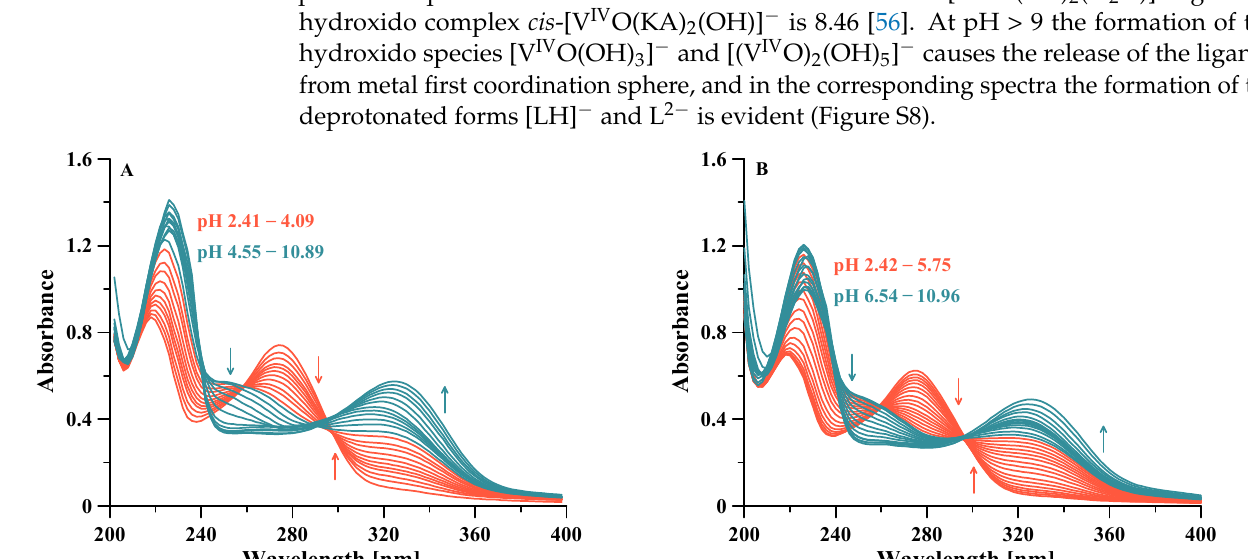
Figure 3. Representative spectra of V IV O 2+ -L4 ( A ) and V IV O 2+ -L9 ( B ) both at 1:1 molar ratio collected between 200 and 400 nm, l = 0.2 cm at 25 °C, 0.1 M NaCl ionic strength and ligand concentration 3 × 10 − 4 M.